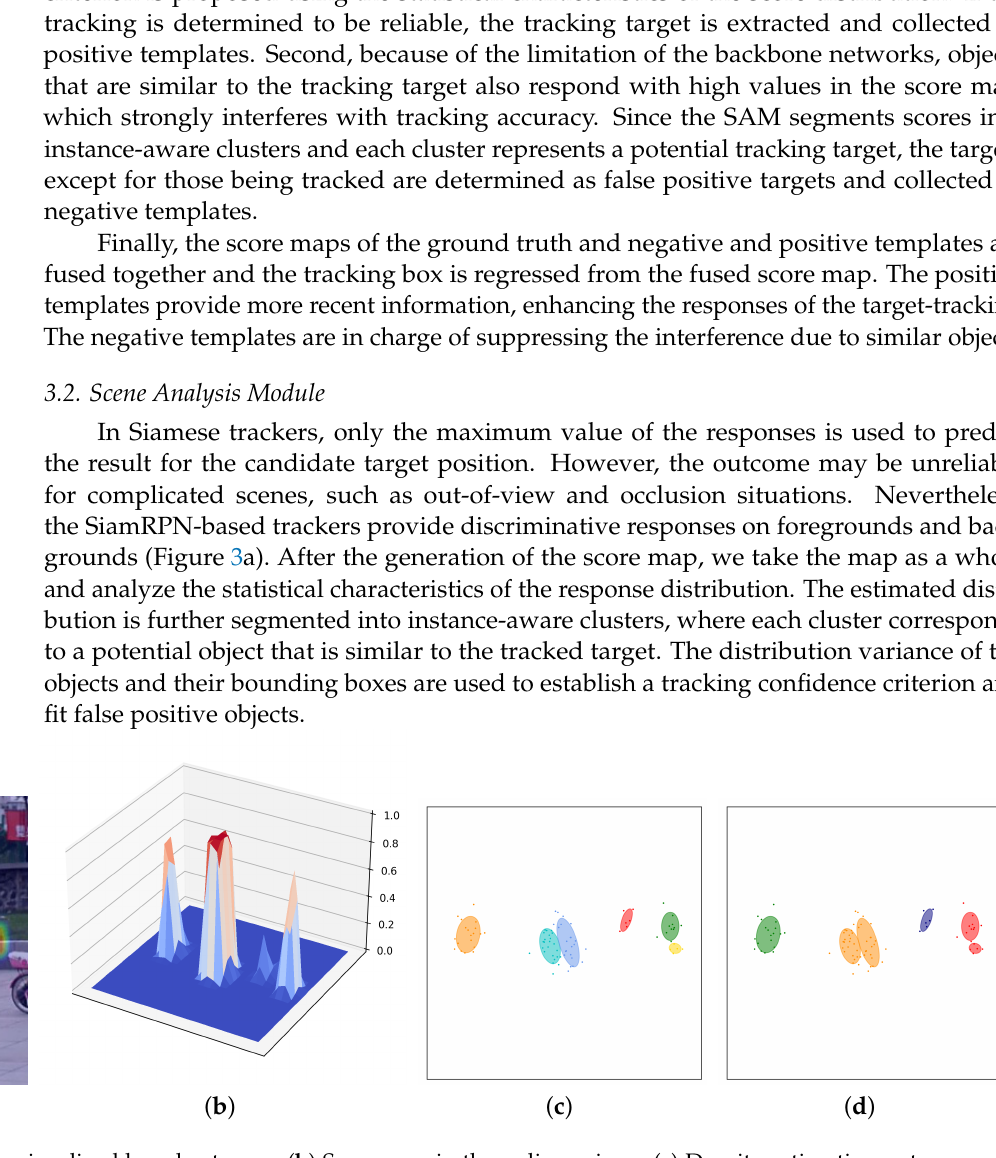
Figure 3. ( a ) Score map visualized by a heat map. ( b ) Score map in three dimensions. ( c ) Density estimation outcome of GMM. The GMM components are visualized using ellipses in different colors. ( d ) Instance segmentation. The GMM components are further segmented in instance-aware clusters, where each cluster corresponds to a potential